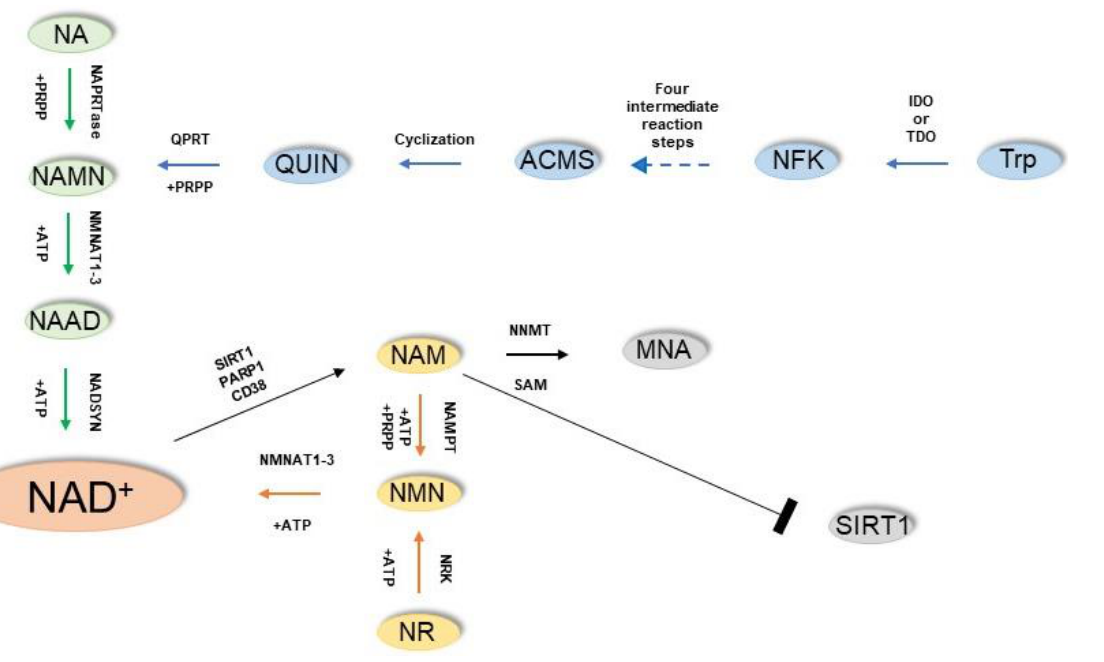
Figure 1. Pathways of NAD + biosynthesis and major NAD + -consuming enzymes. The Preiss – Handler pathway is highlighted in green; the de novo biosynthesis pathway is in blue; the NAD + salvage pathway is in yellow.